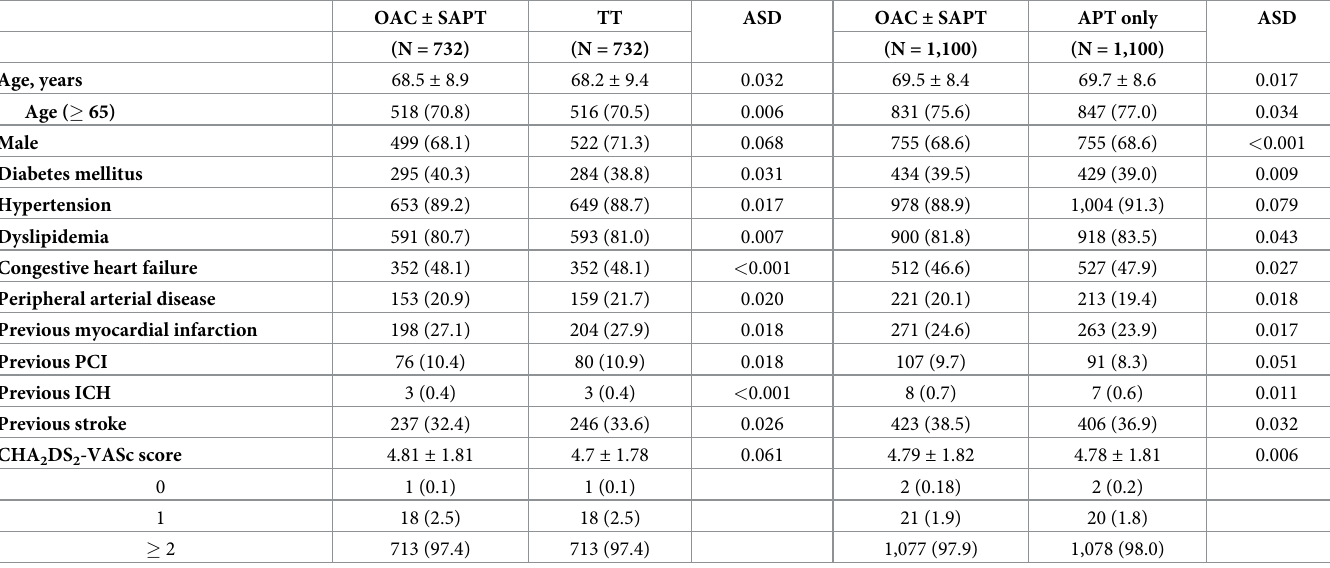
Table 3. Characteristics of propensity score matched population according to antithrombotic regimen at 1-year after